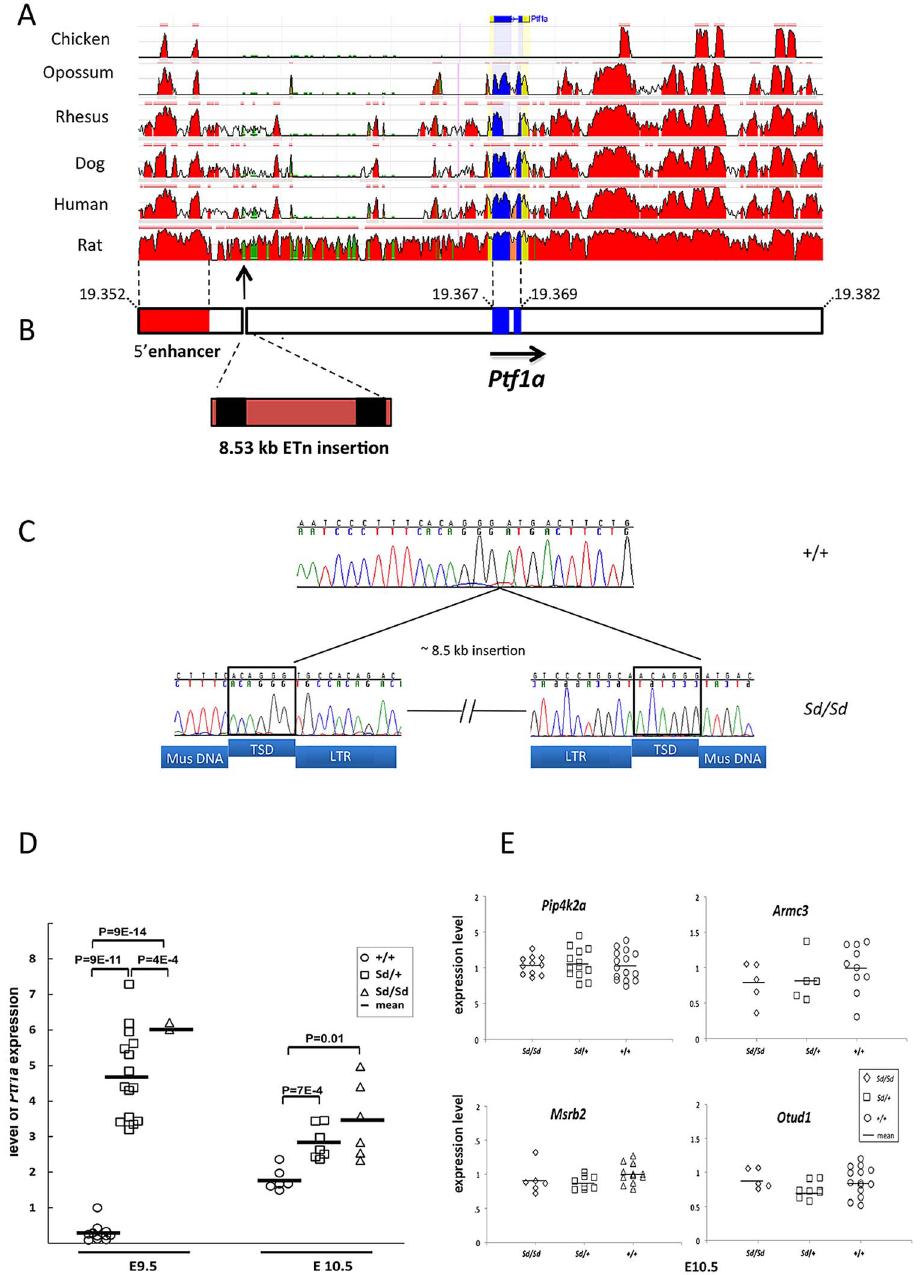
Figure 2. The Sd mutation is an insertion in the 5 9 regulatory of Ptf1a . (A) Conservation of the Ptf1a genomic region across vertebrate species (ECR Browser at dcode.org). The height of the red peaks indicates the level of conservation. The Ptf1a exons are shown in blue. The Sd insertion is shown by the arrow. There is a highly conserved 5 9 enhancer upstream of the Sd mutation (shown in red, located between positions 13.4–15.6 kb upstream of the Ptf1a start site). (B) Schematic representation of the Ptf1a locus. Sequence coordinates are shown in Mb (build 37.2). The Ptf1a exons are shown in blue. The location of the highly conserved 5 9 enhancer element is shown in red. The Sd mutation is an insertion of an 8.527 kb ETn at nucleotide 19,355,020 on Chr. 2. The LTRs are indicated in black. The full sequence of the element is in Table 1. (C) Electropherogram of the site of the insertion in wild-type and Sd/Sd mutant mice. The target site duplications (TSD) are boxed. The sequences corresponding to LTRs, TSD and mouse genomic DNA (Mus DNA) are indicated below the nucleotide sequence. (D) Quantitative PCR of whole embryo shows up to 10-fold increased expression of Ptf1a at E9.5 in Sd/Sd mutants. Ptf1a expression remains significantly at E10.5. P-values for comparisons are indicated (t-test). (E) Quantitative PCR of whole embryo of neighboring genes with mammalian orthologs did not reveal any differences in expression between Sd mutants and wildtype mice (p . 0.2 for all comparisons). mutant strain, which was absent in the RSV/LeJ background ancestral haplotype that is shared by at least eleven laboratory strain and twenty-five wild-derived or classical inbred strains. SNP strains, including RSV/LeJ and three strains used in the derivation analysis of the Ptf1a locus suggests that the mutation arose on an of this laboratory strain (C57BL/6J, CBA/J and C3H/HeJ). Our